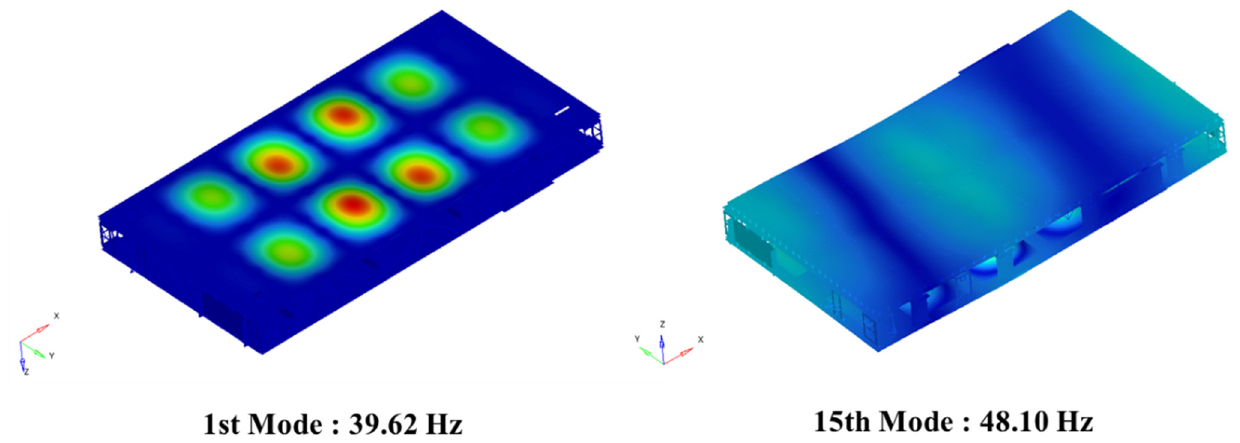
Figure 12. Modal analysis results obtained under the on-orbit configuration.